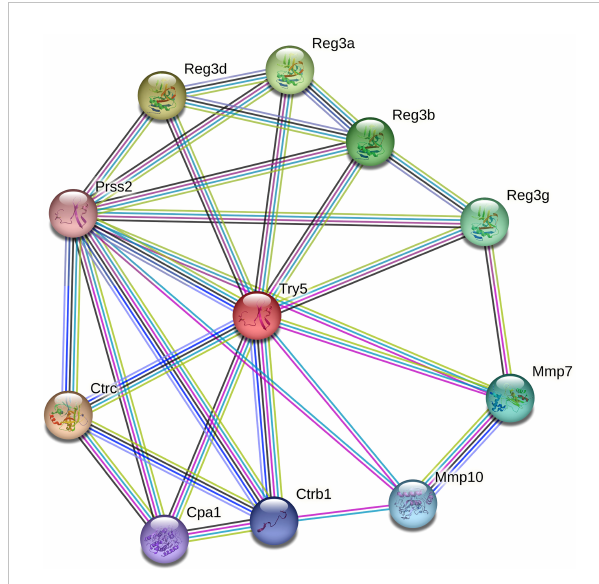
FIGURE 3 The protein-protein interaction network of Try5. The protein- protein interaction analyses were performed using the STRING database. Shown are Try5 (Trypsin 5) and its top 10 protein interactors (listed clockwise): Reg3a (Regenerating islet-derived 3 alpha), Reg3b (Regenerating islet-derived 3 beta), Reg3g (Regenerating islet-derived 3 gamma), Mmp7 (Matrix metallopeptidase 7), Mmp10 (Matrix metallopeptidase 10), Ctrb1 (Chymotrypsinogen B1), Cpa1 (Carboxypeptidase A1), Ctrc (Chymotrypsin C), Prss2 (Protease, serine 2), and Reg3d (Regenerating islet-derived 3 delta). Different line colors represent different types of interaction evidence between the